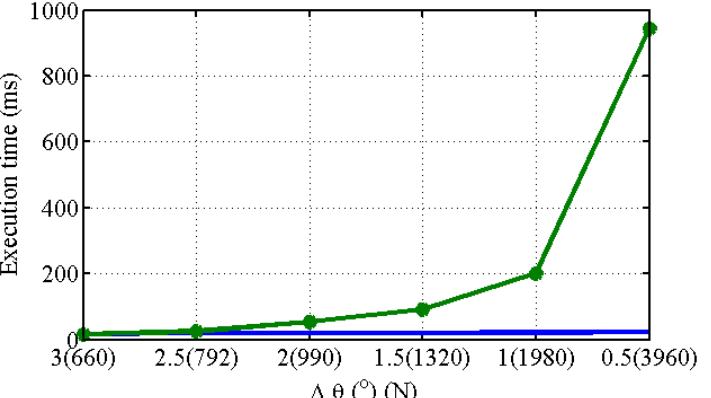
Figure 9. The comparison of execution time for the proposed parallel model on CPU and GPU.